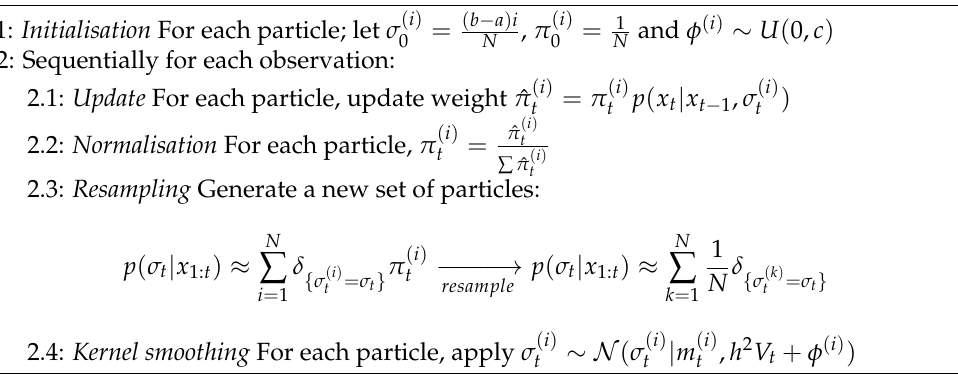
Algorithm 4 Filtering algorithm incorporating selection of the rate of adaptation